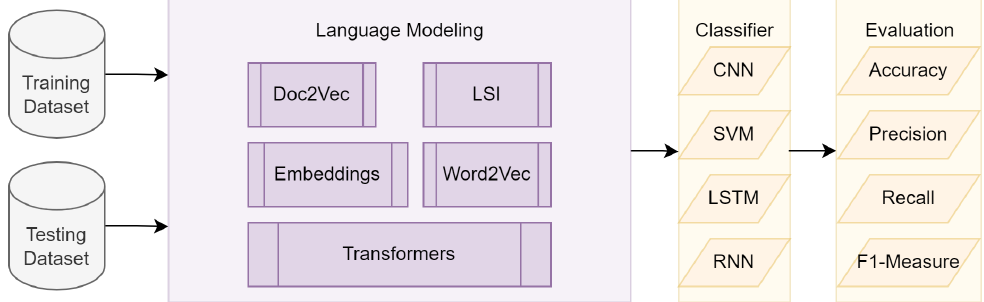
Figure 1. Overall working process of NLP-based malware detection: ( Left ), Datasets ( Middle ), NLP Modeling ( Right ), Classification and